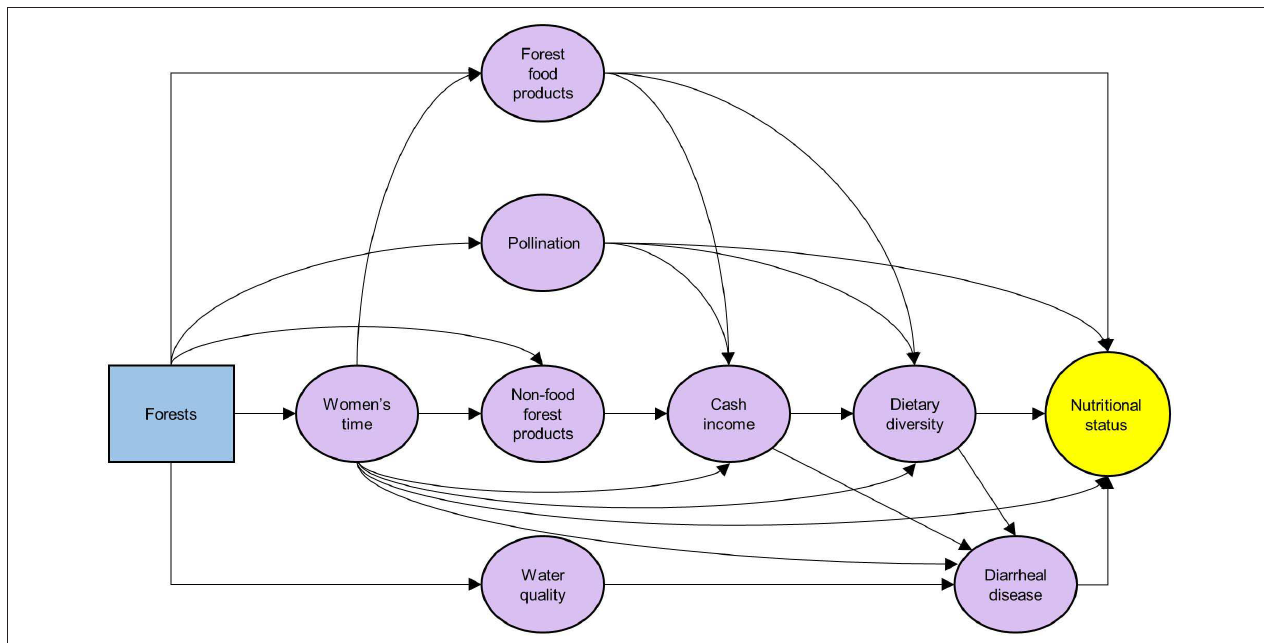
FIGURE 1 | Mechanistic pathways linking forests and nutritional status (purple oval boxes: underlying determinants of nutrition addressed by